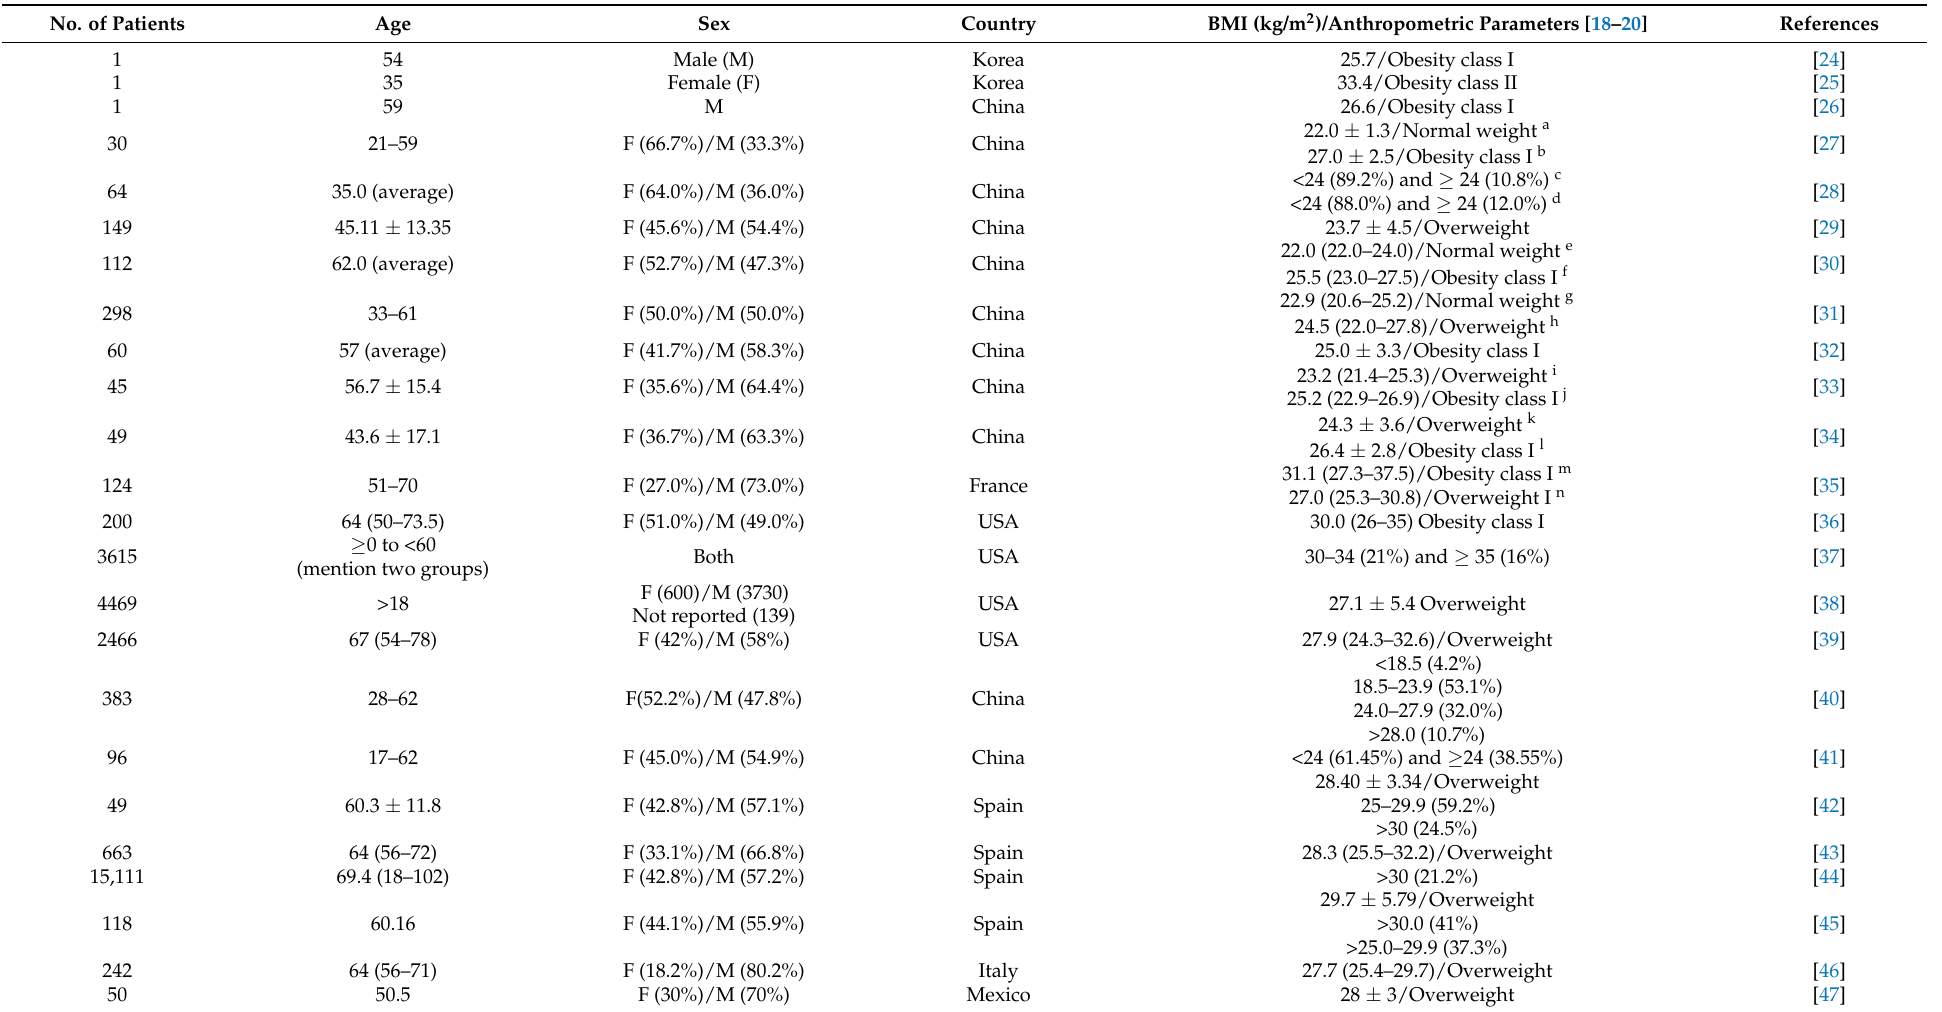
Table 3. Summary of articles with data on BMI in COVID-19 infected